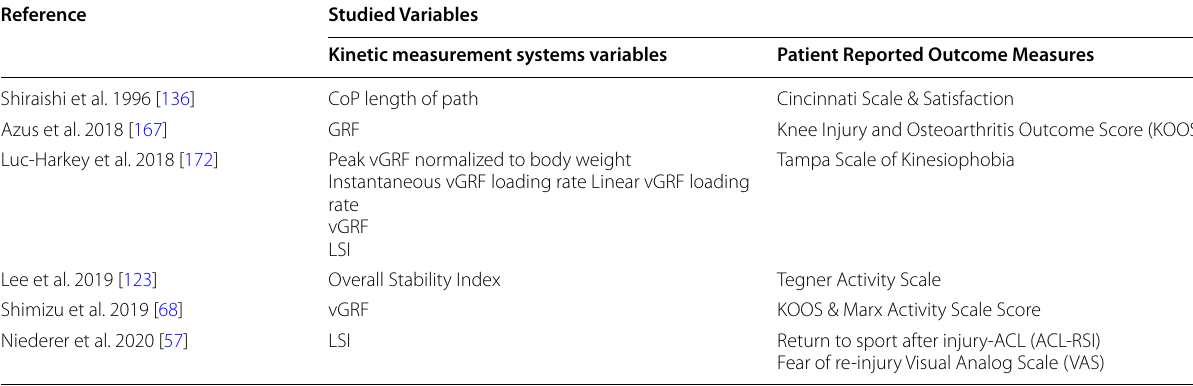
Table 6 Studies examined the association between kinetic measurement systems variables and PROMs